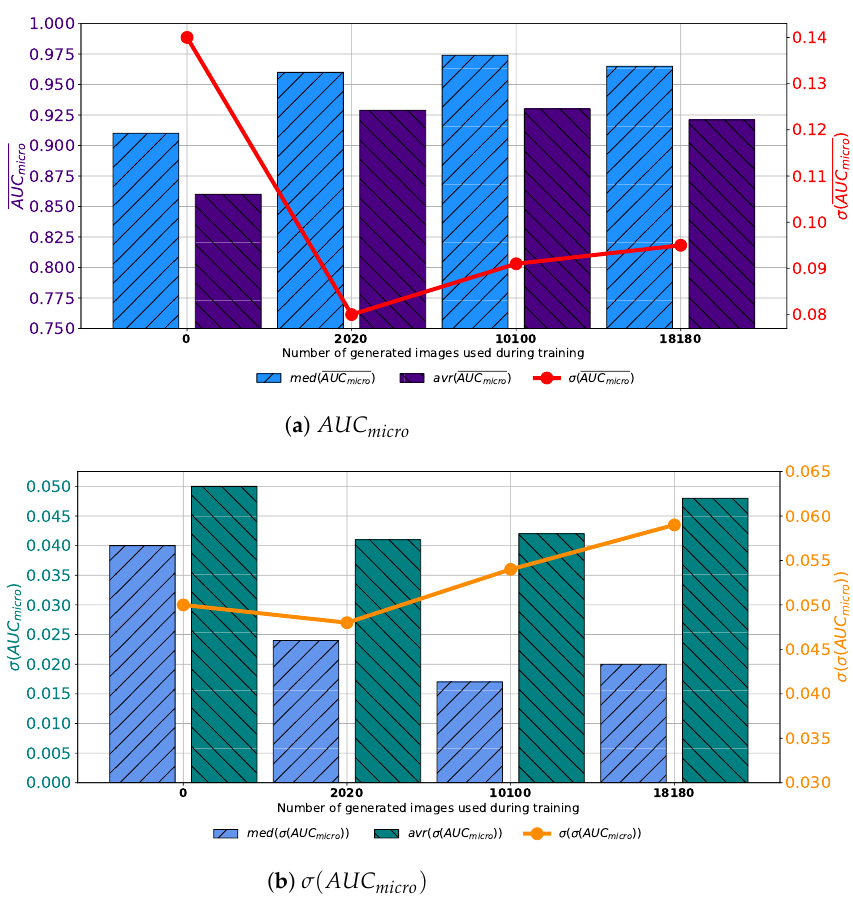
Figure 8. Median, average AUC micro and standard deviation of AUC micro and σ ( AUC micro ) for the case of AlexNet trained with images generated by GAN in 250